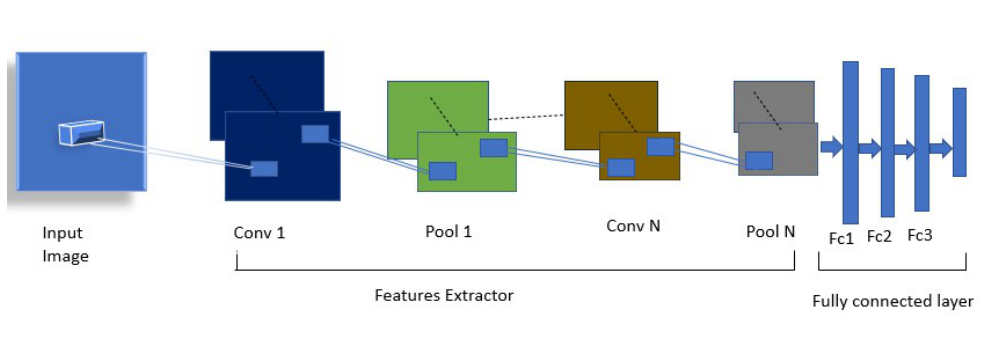
Figure 2. The architecture of a convolutional neural network